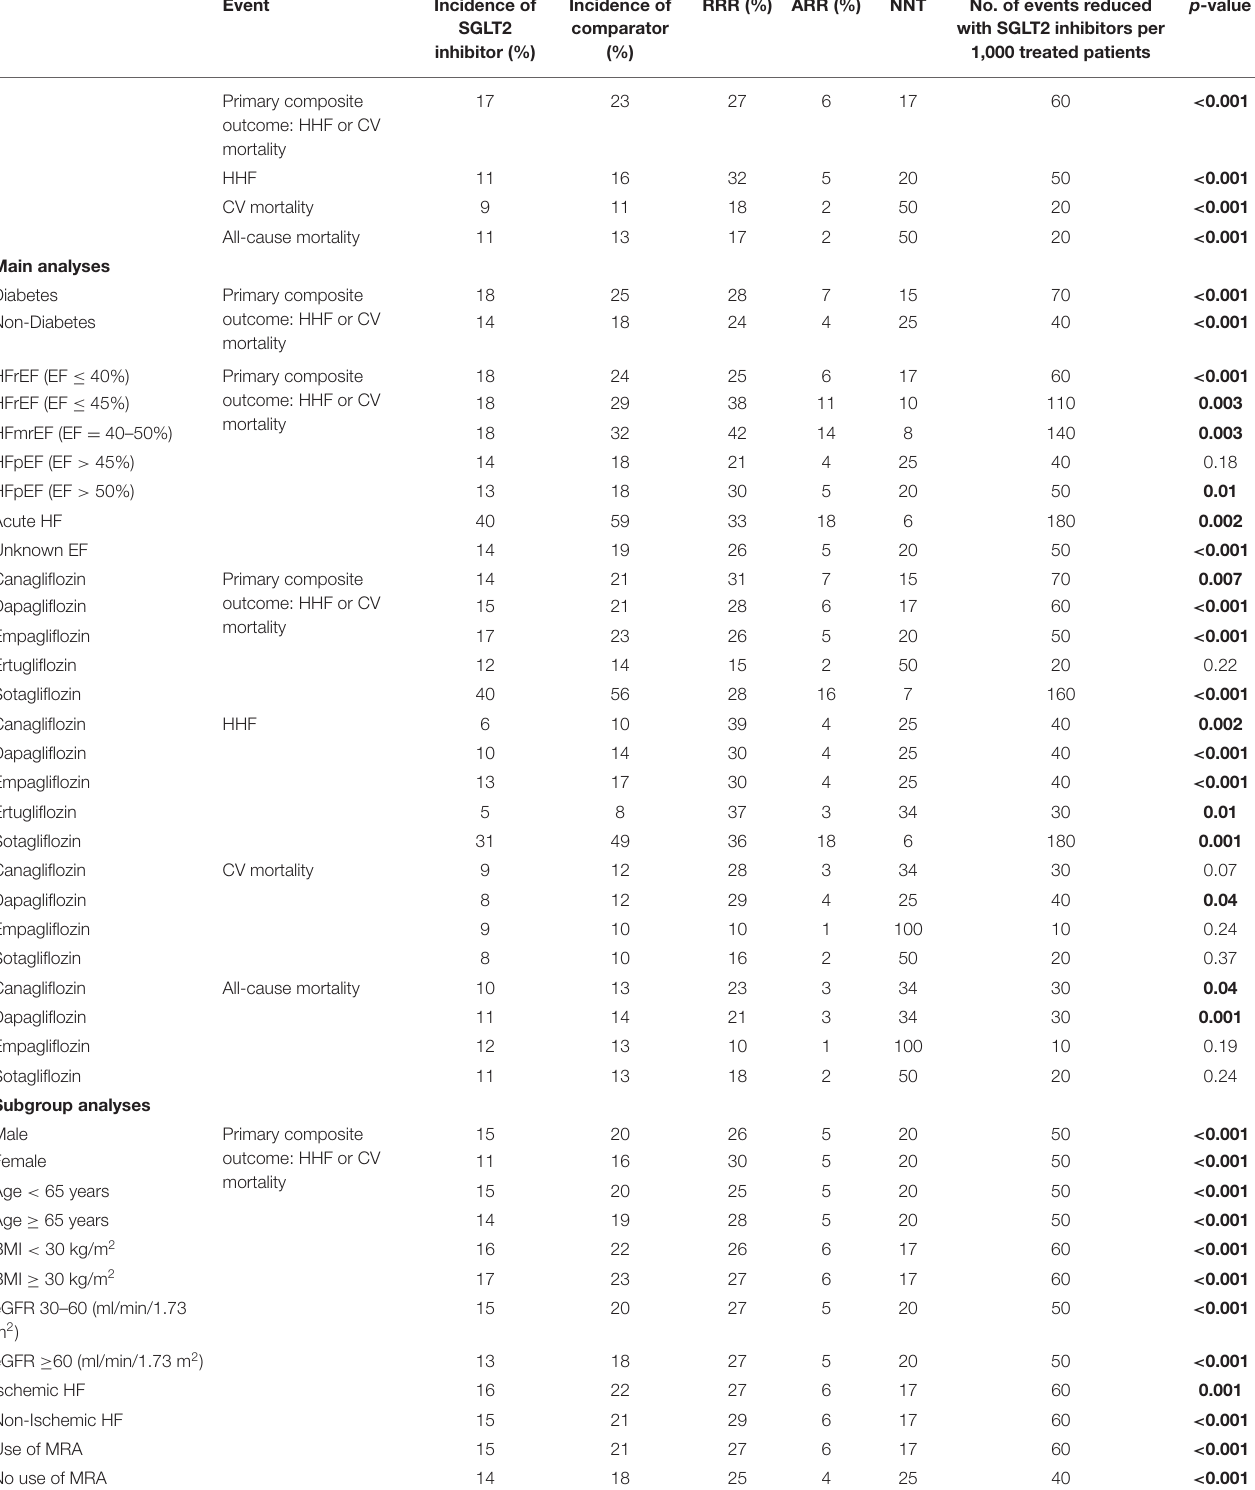
TABLE 2 | Incidence, relative risk reduction (RRR), absolute risk reduction (ARR), and number needed to treat (NNT) for the primary composite endpoint and secondary endpoints. Event Incidence of